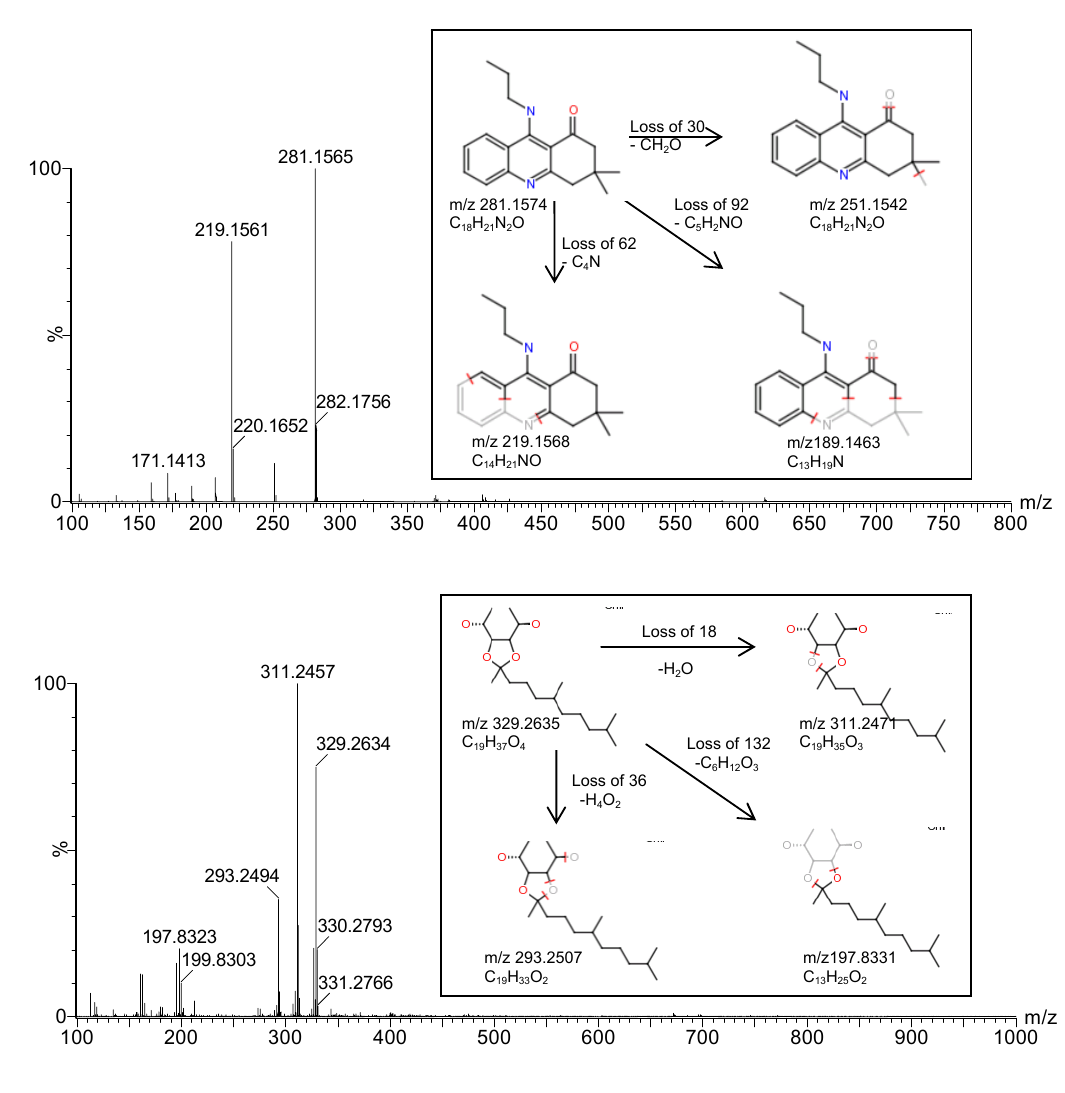
Figure 3. TOF MS–MS spectra and proposed fragmentation (insets) of compound 1 (above) and compound 18